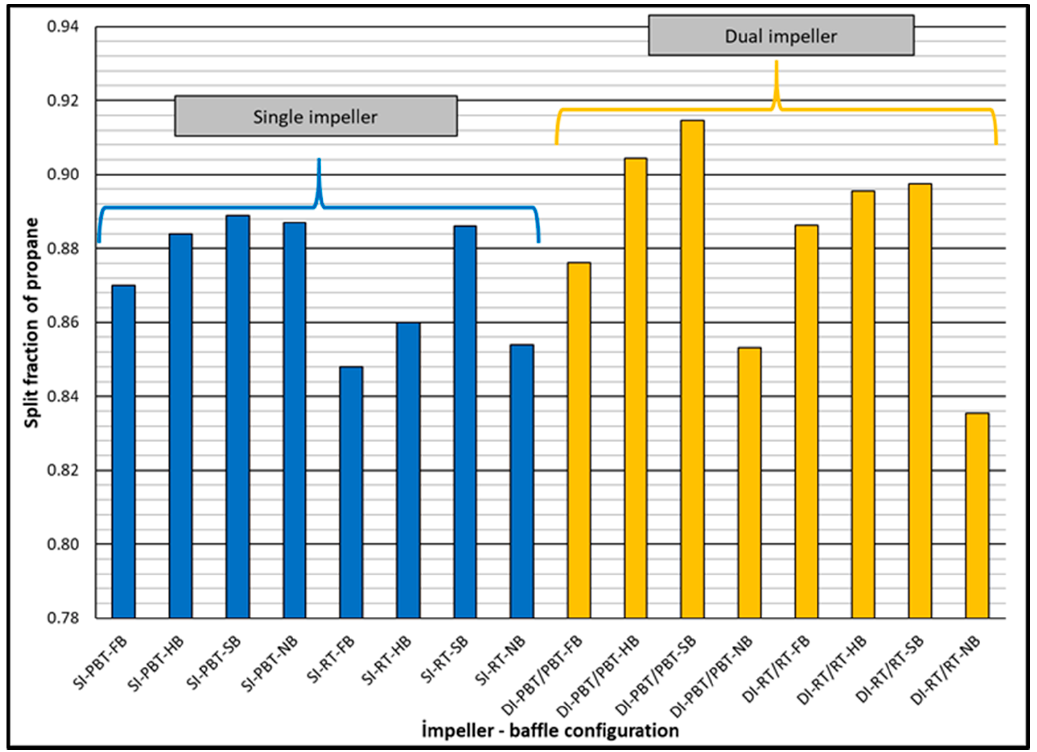
Figure 7. Split fraction of propane for single and dual impeller experiments (experimental temperature 2 °C).